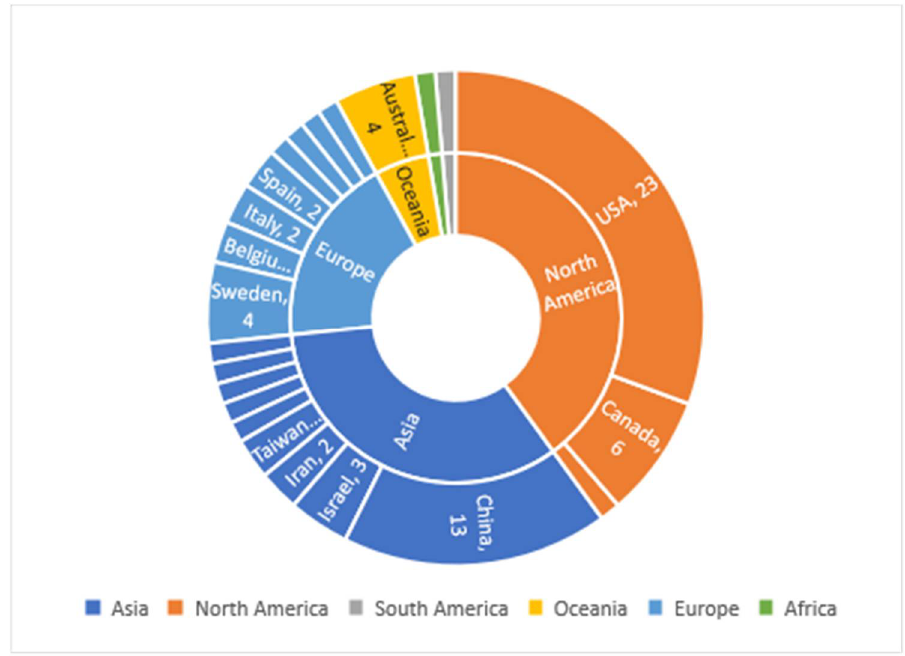
Figure 2. Geographic scope of all original articles reviewed.